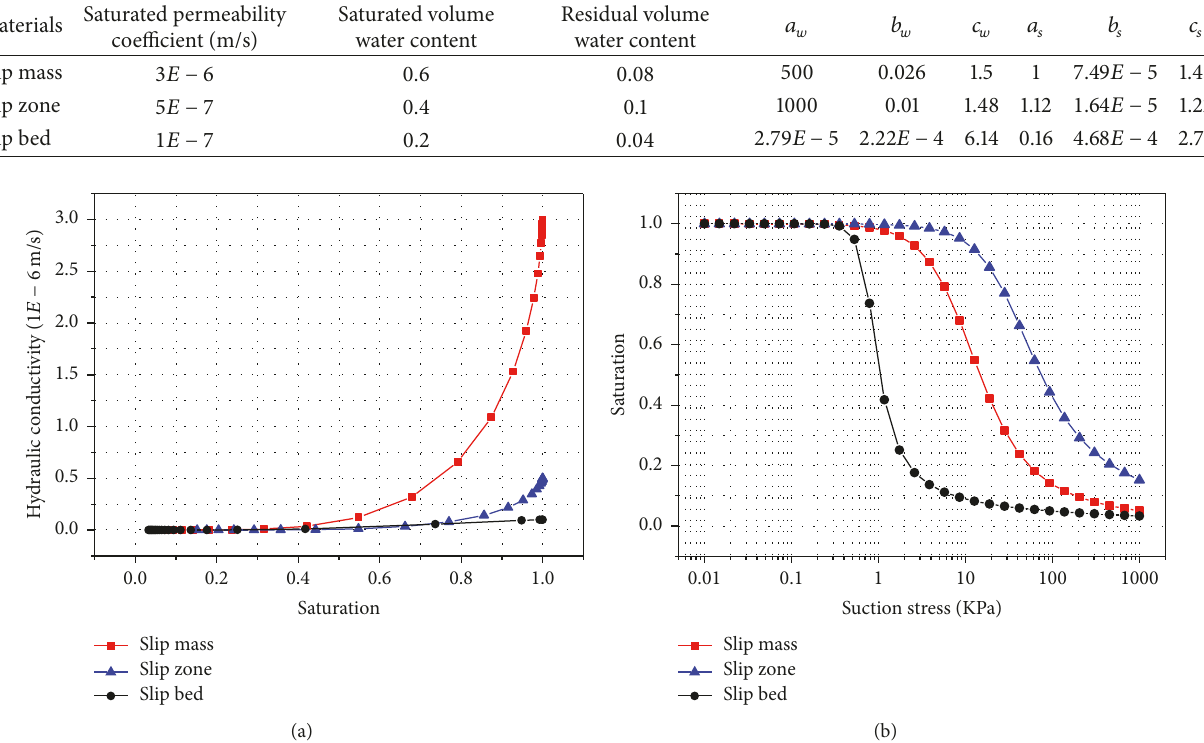
Figure 7: (a) Hydraulic conductivity function (HCF); (b) soil-water characteristic curve